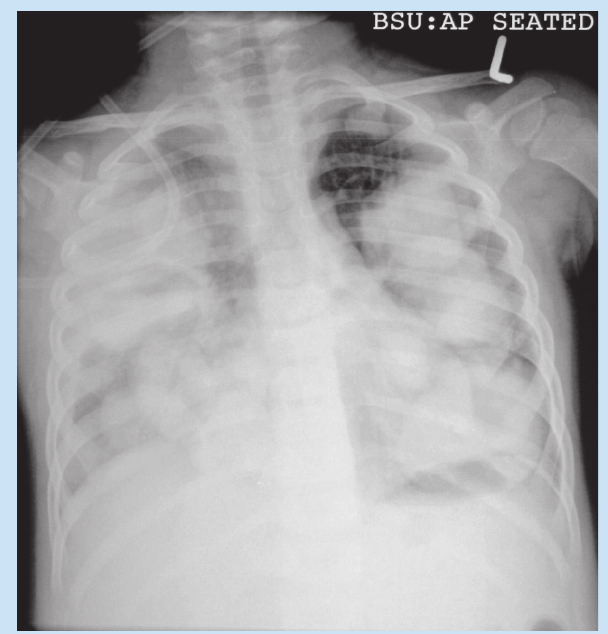
Fig. 1. Chest X-ray demonstrating multiple well-rounded opacities in both lung fields.